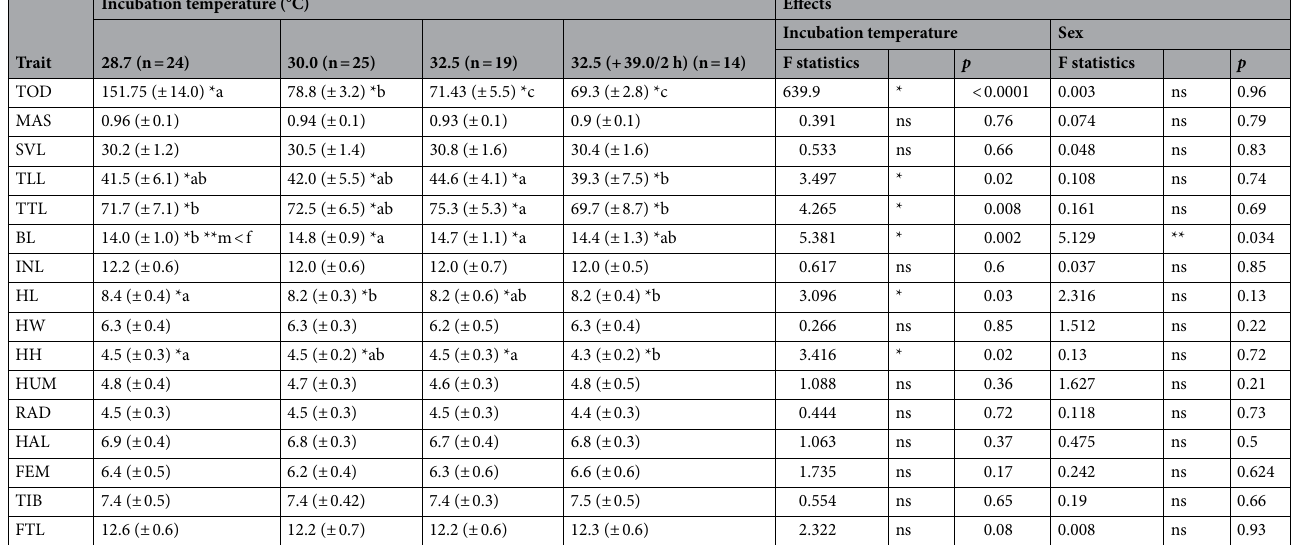
Table 3. Effects of incubation temperature on development time and morphological traits of Tropidurus torquatus newborns under four temperature regimes. BL body length, FEM femoral length, FTL foot length, HH head height, HL head length, HUM humeral length, HW head width, INL interbrachial-nasal length, MAS newborn mass, RAD radial (forearm) length, SLV snout-vent length, TIB tibial (foreleg) length, TLL tail length, TOD time of development, TTL total length. Significant effect of incubation temperature is indicated by (*) and significant effect on sex indicated by (**); letters *a, *b, & *c denotes the post-hoc difference among treatments; letters **m & **f denotes the post-hoc difference among sex; F, ANCOVA result; ns not significant; p , ANCOVA significance.